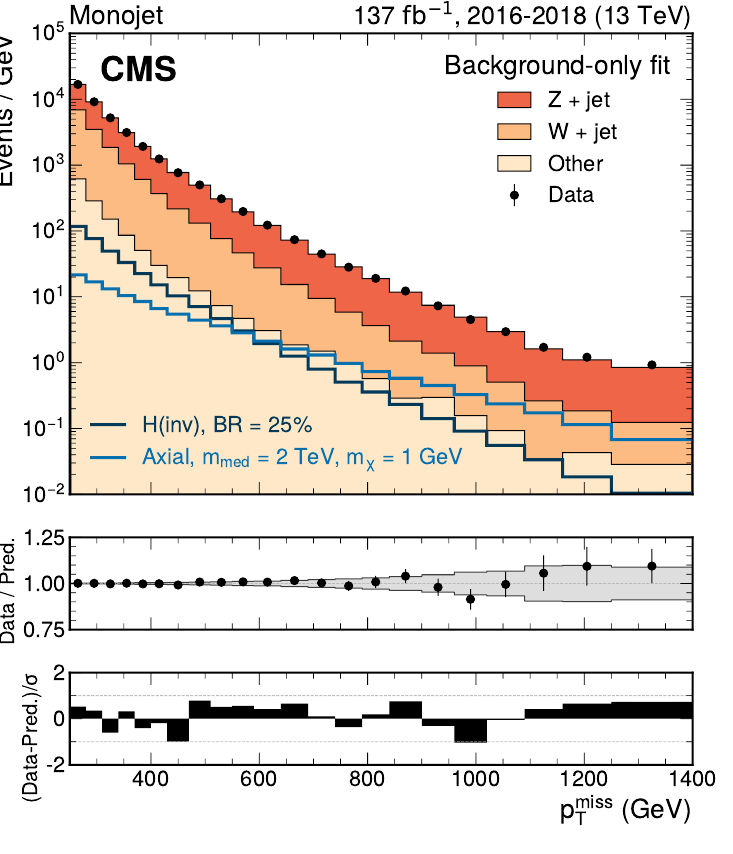
in the monojet category. The distribution is shown including the Figure 25 . Distribution of p miss T contributions from all data taking years. It does not directly represent the input to the statistical method, which instead relies on distributions separated by data taking year. The background estimate is obtained from the background-only fit to all data taking periods, regions, and categories, including mono-V. The total uncertainty in the background estimate, shown as a gray band in the middle panel, takes into account all relevant correlations. The signal templates from the Higgs portal and axial-vector mediator hypotheses are overlaid (solid lines). In both cases, contributions from all production modes are taken into